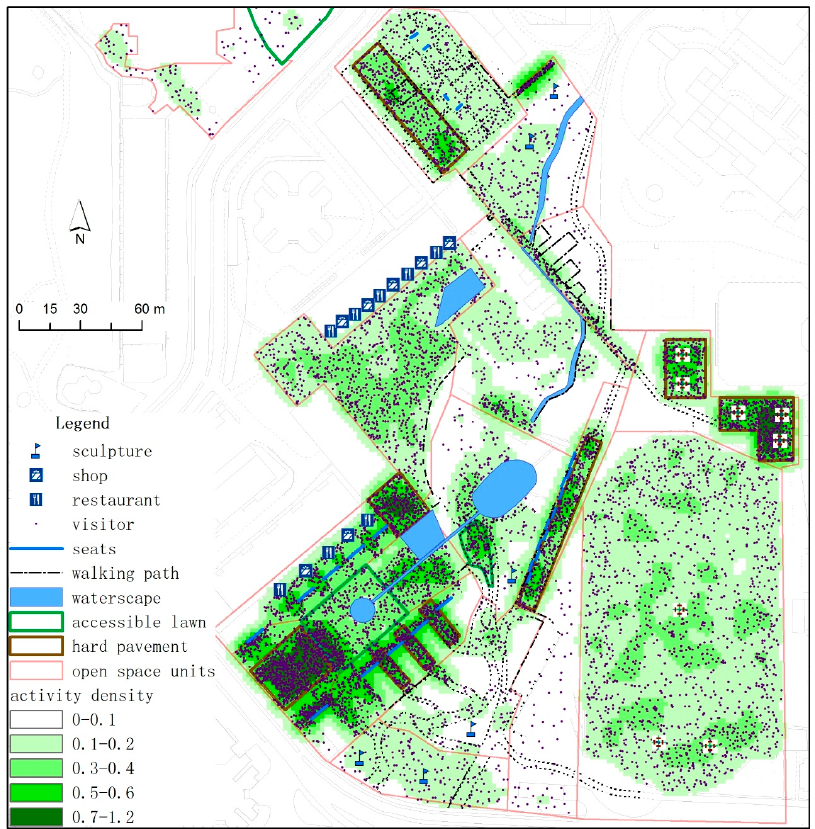
Figure 3. Map showing the activity density in the Ecological Square Park.